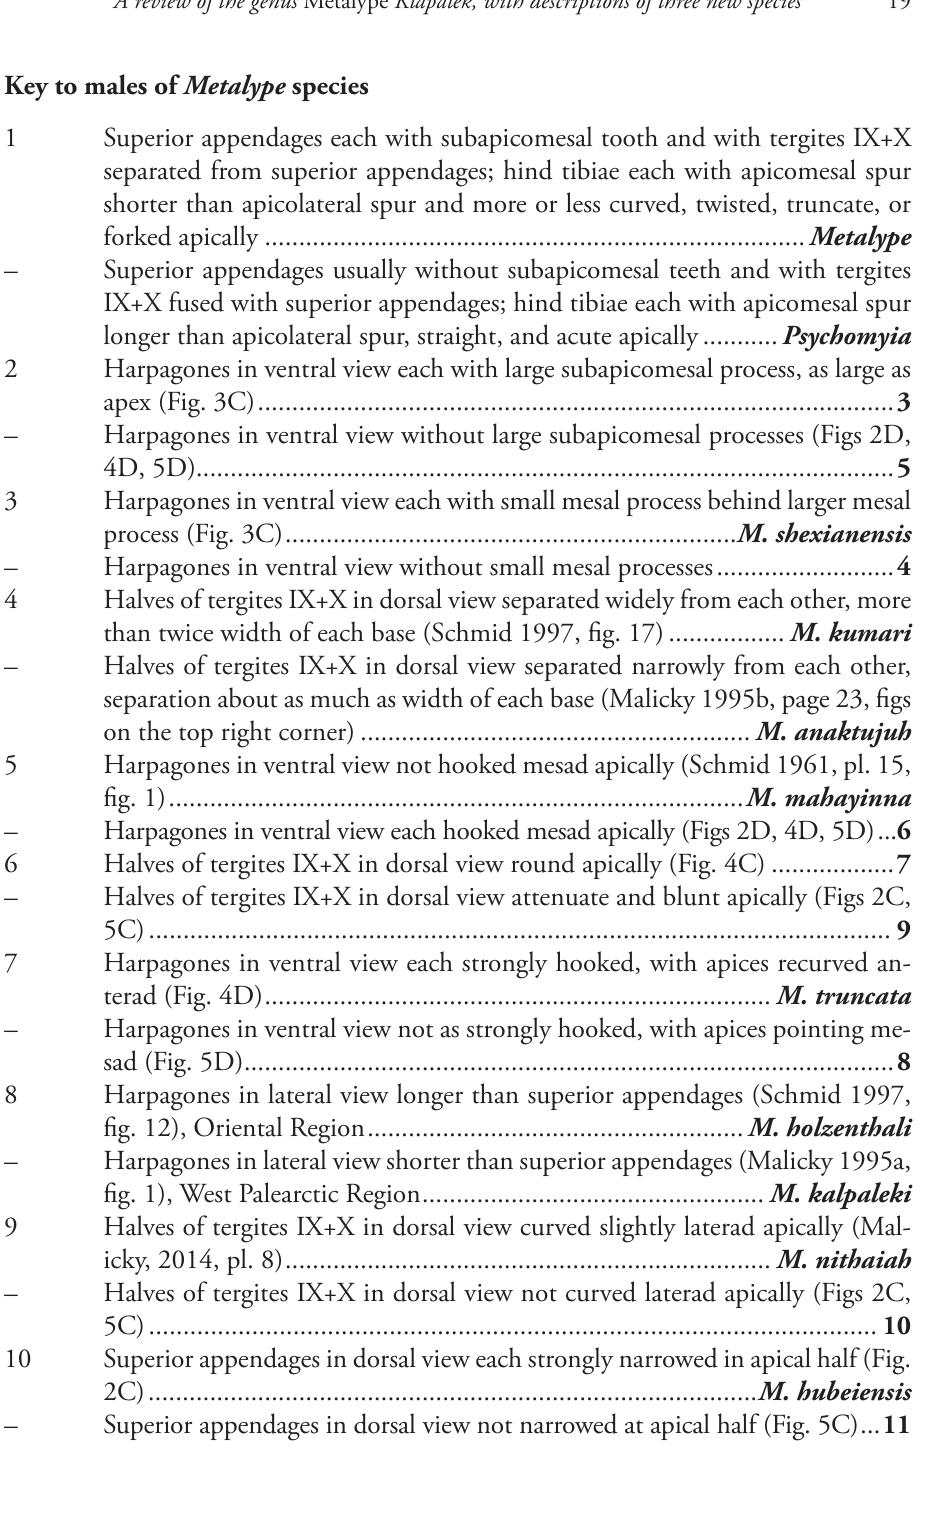
Halves of tergites IX+X in dorsal view not curved laterad apically (Figs 2C, Superior appendages in dorsal view each strongly narrowed in apical half (Fig. Superior appendages in dorsal view not narrowed at apical half (Fig. 5C) ...